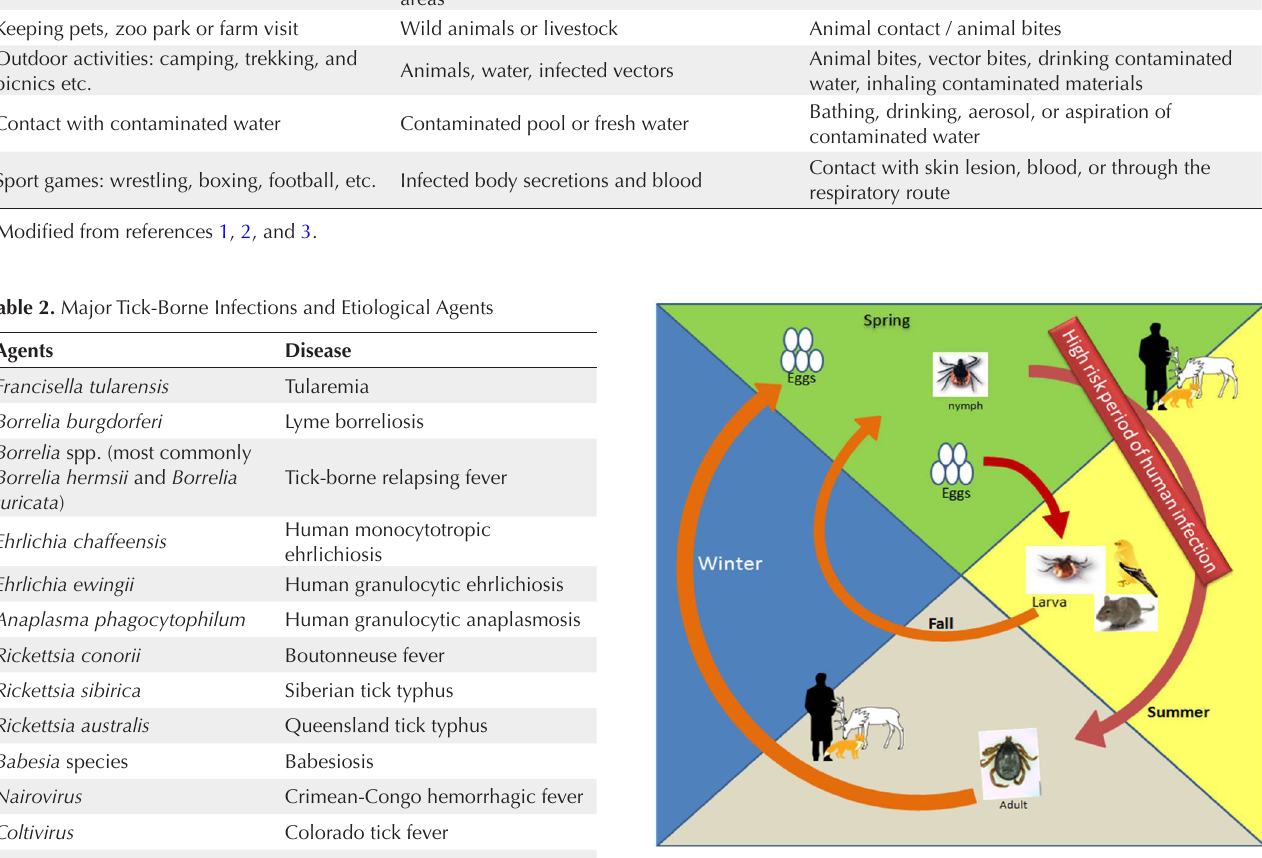
Figure 1. Life cycle of ticks in nature (modified from references 5 and 6).